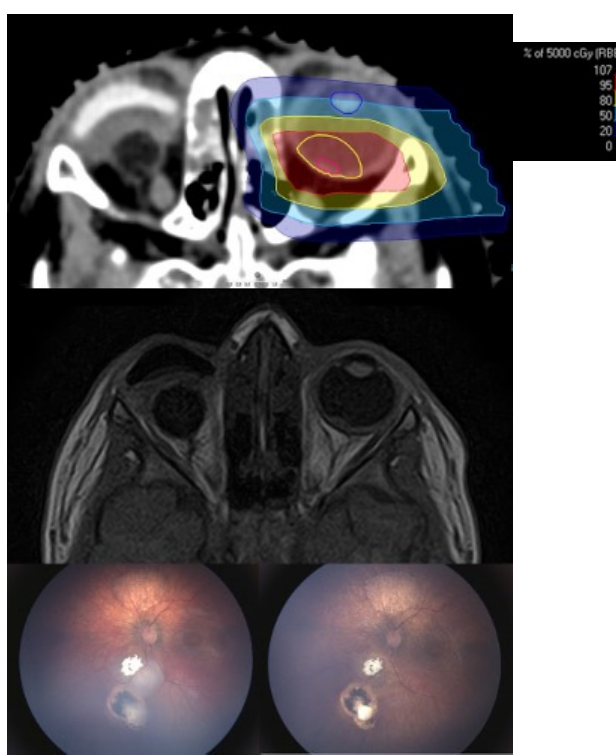
Figure 1. (Case 2): 21 old month male patient before and after proton beam therapy. The top figure shows the irradiation plan (gross tumor volume (GTV): red and clinical target volume (CTV): yellow) and middle figure the corresponding magnetic resonance imaging (MRI) before proton beam therapy (PBT). Note the sparing of the lens and the small bony window. The lower left picture shows two recurrent tumors close to the optic disc. Intraarterial chemotherapy was not feasible due to insufficient visualization of the ophthalmic artery. The lower right picture shows the result after a follow-up of 16 months. Best-corrected visual acuity was 20/40 Snellen acuity.